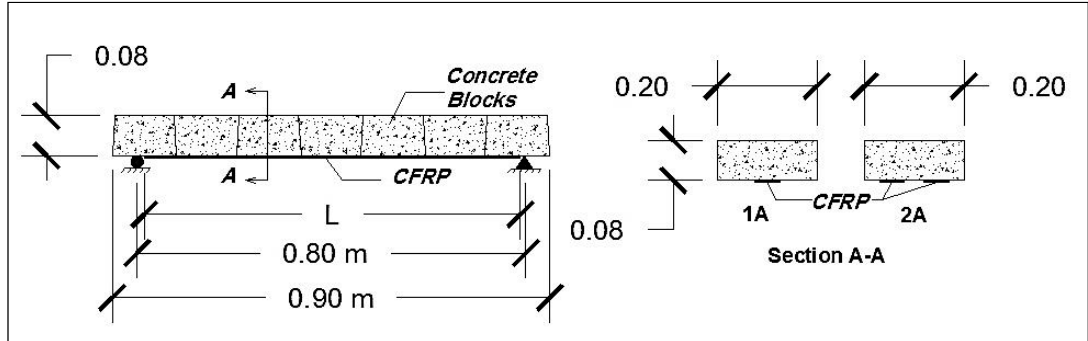
Figure 2. Segmental beam layout.